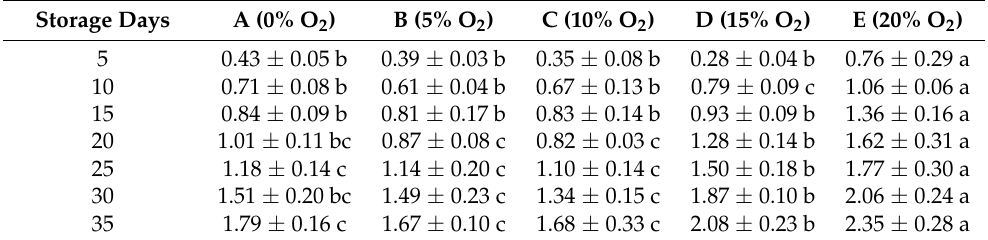
Table 1. Changes in the weight loss rate of eggs under different oxygen (O 2 ) concentrations during storage.